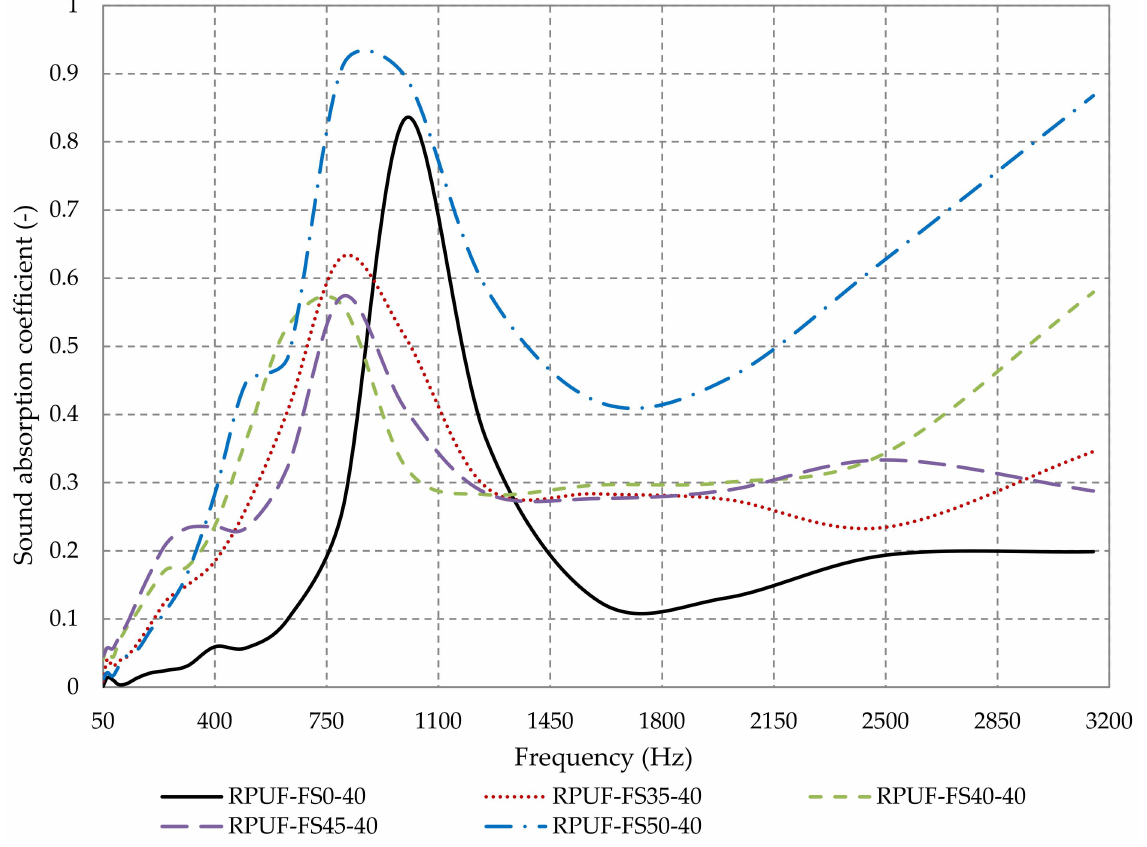
Figure 9. Sound absorption coefficient variation with the fir sawdust percentage in rigid polyurethane foam